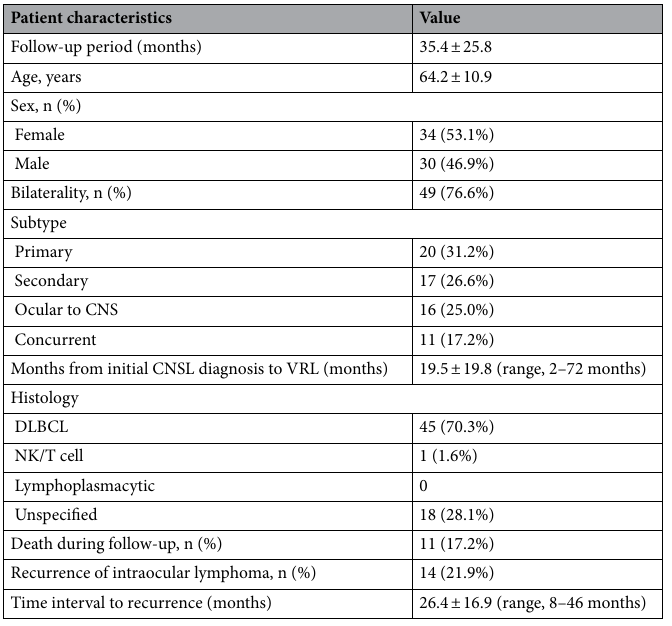
Table 1. Baseline demographics and disease characteristics of patients with vitreoretinal lymphoma. Data are expressed as mean ± standard deviation (95% confidence interval). CNS central nervous system, CNSL CNS lymphoma, DLBCL diffuse large B-cell